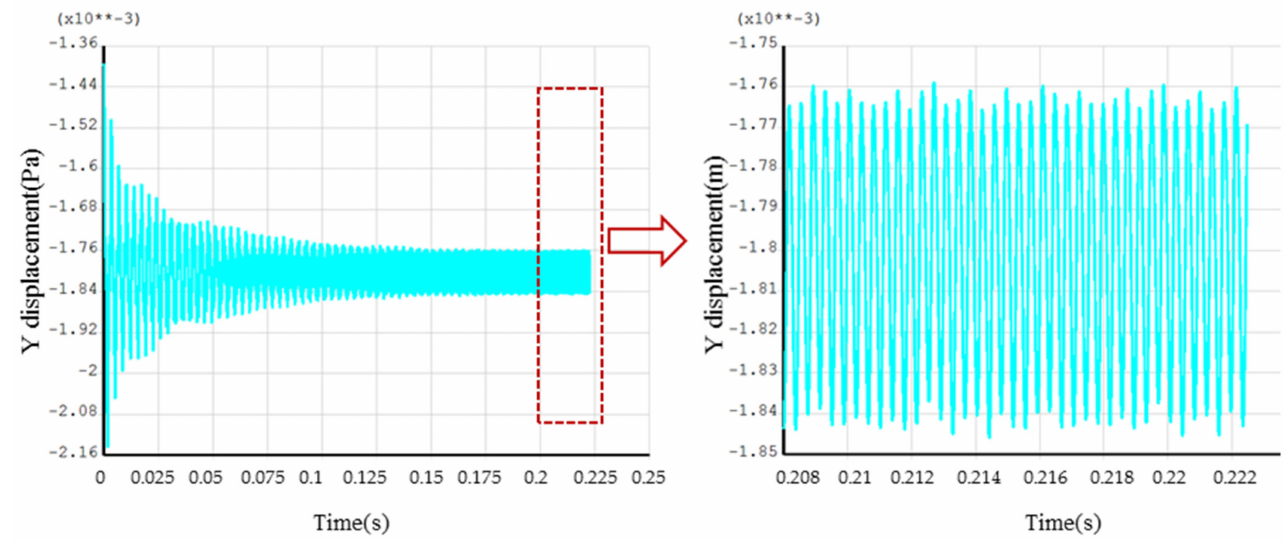
Figure 19. Convergence of transient dynamic